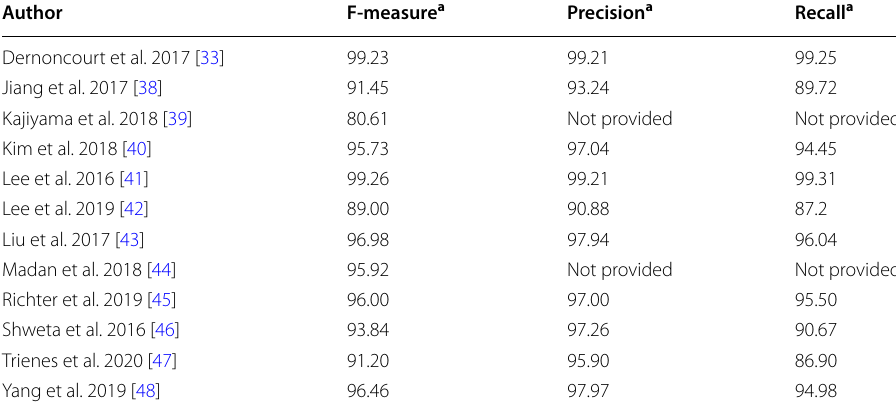
a All scores shown are percentages